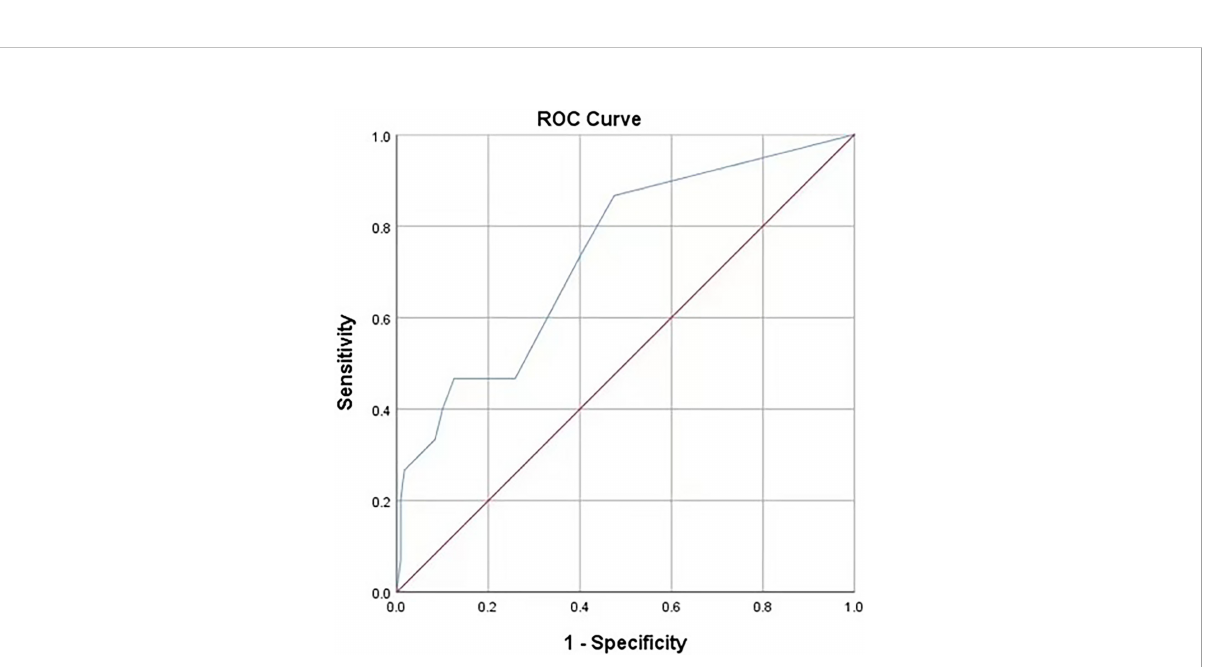
FIGURE 5 Receiver operating characteristic curves of the predictive model based on the internal validation data set. AUC (95%CI)=0.736 (0.602-0.871),